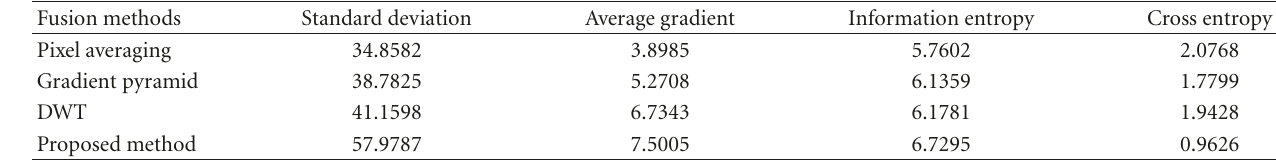
Table 1: Quantitative evaluation results of the four di ff erent fusion methods in Figure 7.